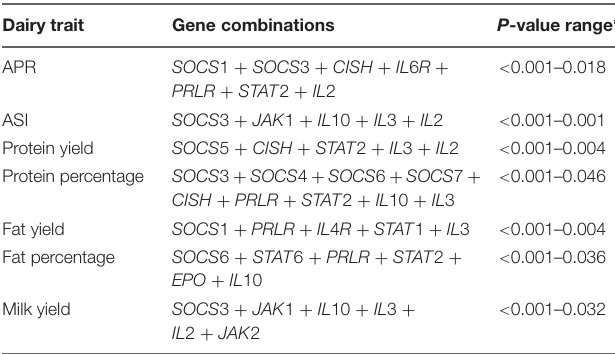
TABLE 2 | Janus kinase and signal transducer and activator of transcription ( JAK-STAT) pathway gene combinations associated with dairy traits.